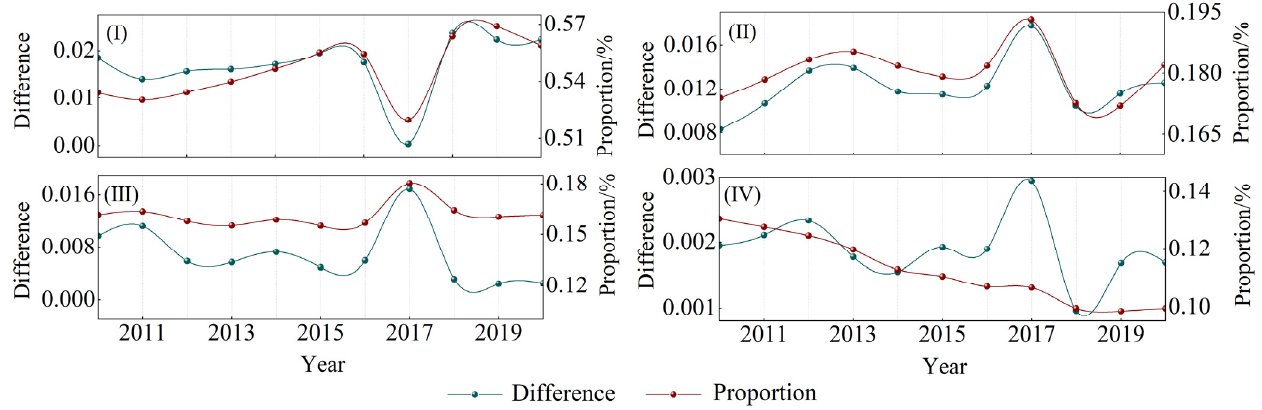
Figure 4. Evolution and decomposition of wheat yield differences in different cultivation areas in the HHH region. ( I ) Hebei, Shandong, and Henan low-lying plains. ( II ) pre-mountain plain area in Yanshan and Taihang Mountains. ( III ) Huang-Huai plain area. ( IV ) Shandong hilly area.